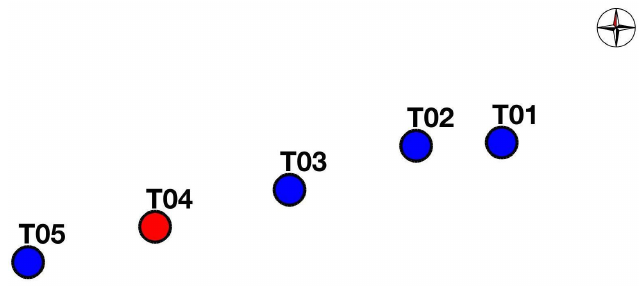
Figure 1. The layout of the wind farm. Table 1. Inter-turbine distances in